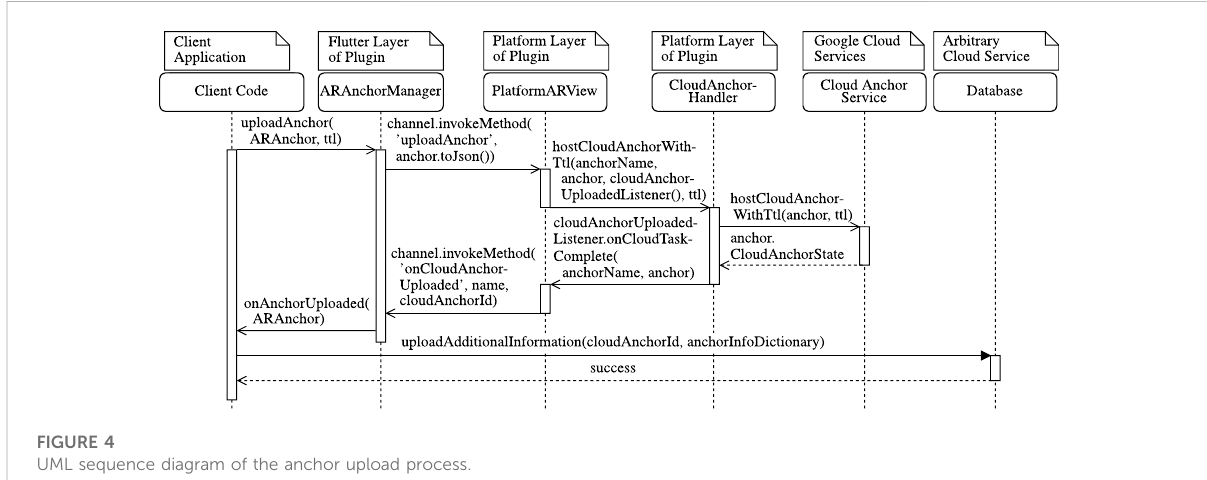
FIGURE 4 UML sequence diagram of the anchor upload